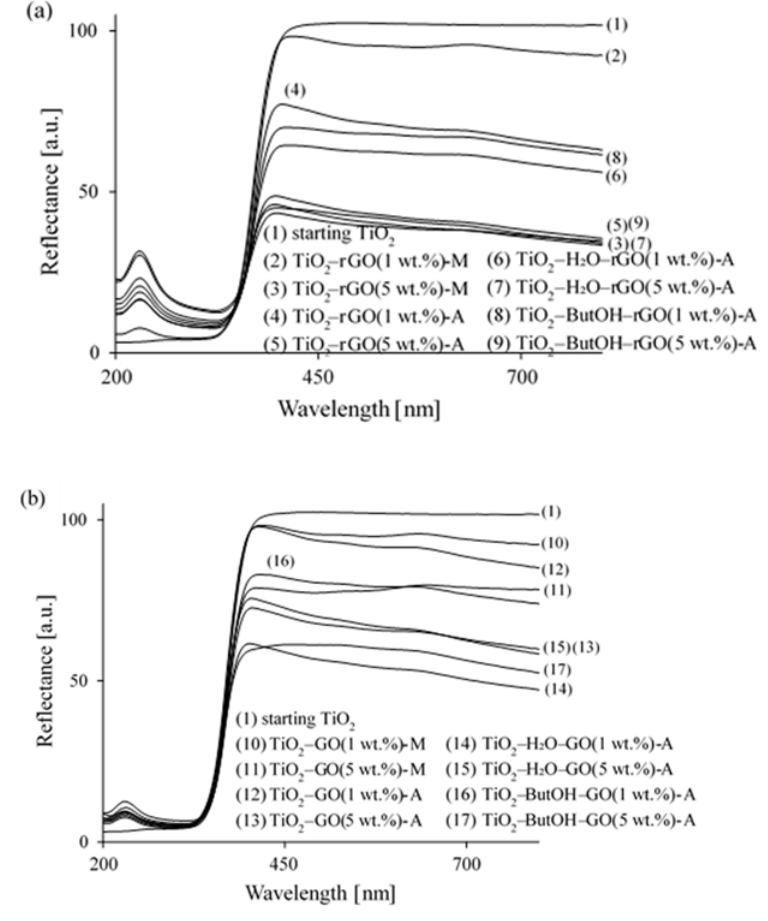
Figure 5 Figure 5. UV-VIS/DRS spectra of ( a ) TiO 2 -rGO and ( b ) TiO 2 -GO hybrid